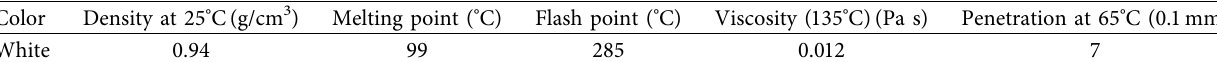
Table 6: The properties of Sasobit